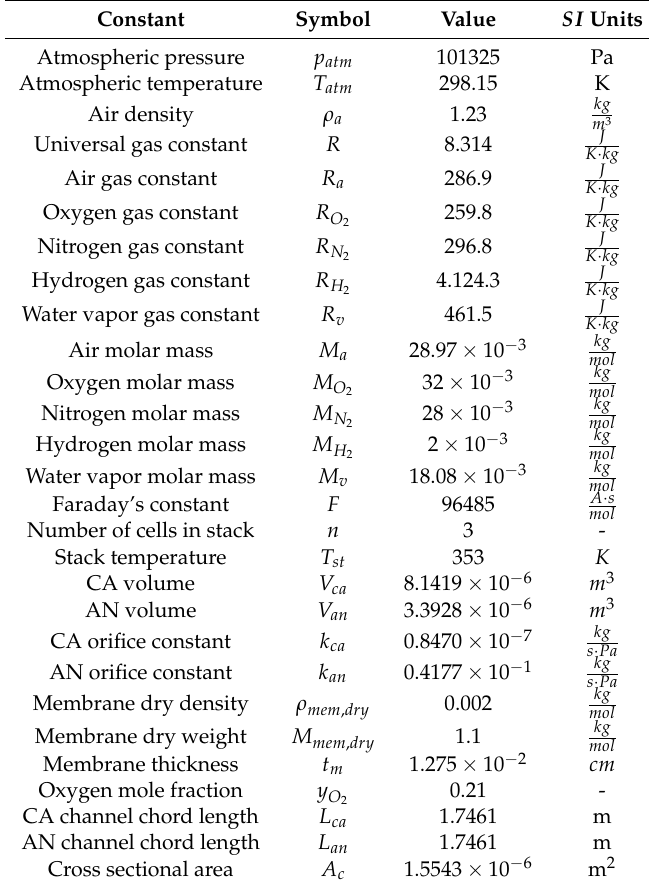
Table A4. Constants present in the derived